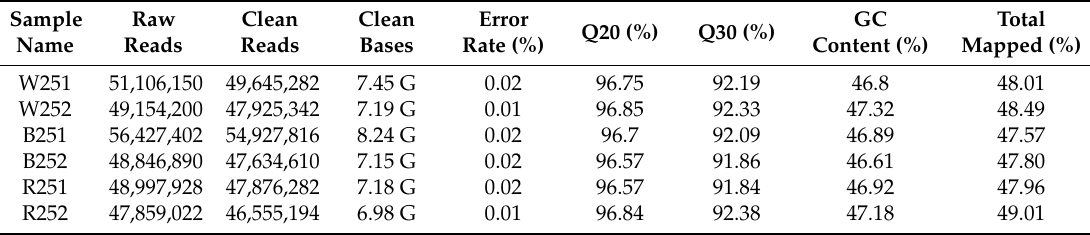
Table 1. Summary statistics of the sequencing